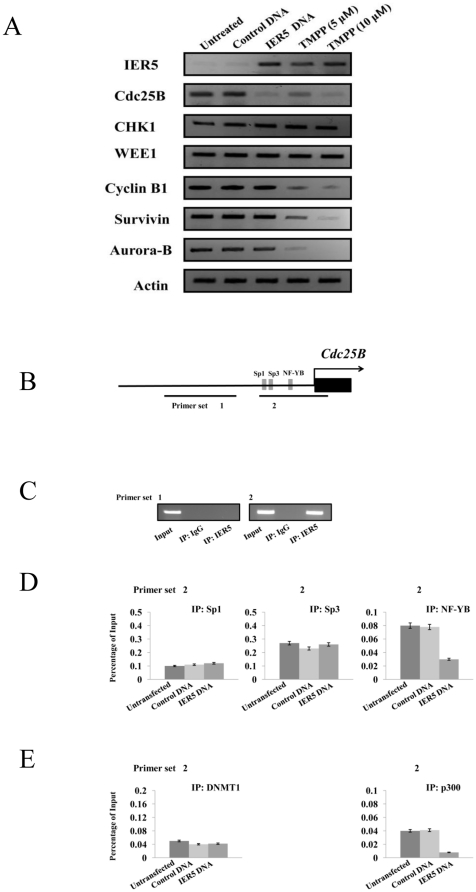
IER5 induced G2/M cell cycle arrest through direct binding to Cdc25B promoter in AML cells.A. U937 cells were transfected with control DNA, IER5 cDNA, or were treated with TMPP (5 µM or 10 µM). The cells were harvested after 3 days, and the expression of the indicated cell cycle regulating proteins was analyzed by SDS-PAGE followed by Western blotting using the indicated specific antibodies. Blotting of Actin was used as a loading control. B. Schematic representation of the human Cdc25B promoter regions, indicating sites for Sp1, Sp3, and NF-YB motifs, amplified from the precipitated DNA by specific primer sets 1 and 2. C. ChIP analysis for IER5 in the Cdc25B promoter. D & E. IER5-dependent changes in Sp1, Sp3 and NF-YB binding (E), and the bindings of coactivators, DNMT1 and p300, to interact with Sp1 and NF-YB, respectively (F) in Cdc25B promoter. U937 cells were either untransfected or were transfected with the control DNA or IER5 DNA. After 3 days culture, cells were cross-linked with 1% formaldehyde and ChIP was performed with either control antibody (IgG) or the anti-IER5 antibody. The precipitated DNA was then assayed by PCR using pairs (primer set 1 and 2) of oligonucleotides encompassing specific regions of the Cdc25B promoter. The values of ChIP efficiencies are given as % of input.